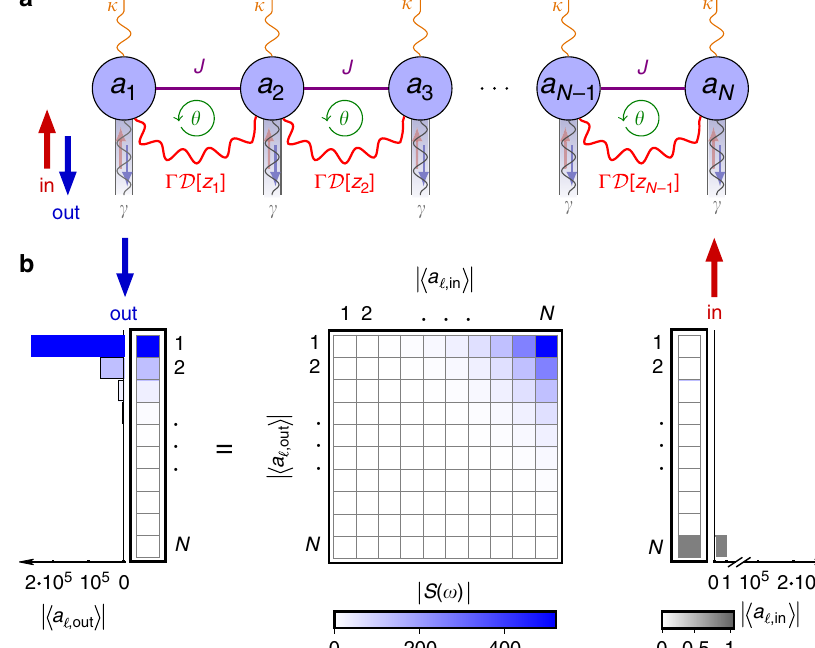
Fig. 1 Directional ampli fi cation in a driven-dissipative chain. a Driven-dissipative chain of N bosonic cavity modes a j evolving according to Eq. (2). Neighboring modes are coupled both coherently with strength J , see Eq. (1), and dissipatively at rate Γ through non-local dissipators D½ z j (cid:2) with z j ≡ a j + e − i θ a j + 1 . Each mode is coupled to a wave guide, which allows probing with a coherent input signal pumping of photons at rate κ enables an amplifying regime for which local dissipation overcomes non-local dissipation, see Eq. (3). b Topologically non- trivial regimes of the chain correspond to non-reciprocal ampli fi cation of a coherent input signal. In the topologically non-trivial regime ν ≠ 0 (here ν = + 1), according to Eq. (11), an input at one end (right) exits ampli fi ed at the opposite end (left). This is quanti fi ed by the scattering matrix S ( ω ) (center) given by Eq. (4). From the structure of S ( ω ), we see that ampli fi cation is directional, i.e., if input and output fi elds are exchanged, the transmission is strongly suppressed. We have chosen N = 10, C ¼ 2 Γ = ð γ þ 2 Γ (cid:3) κ Þ ¼ 2, Λ = 4 J /( γ + 2 Γ − κ ) = 2 and θ ¼ 3 π